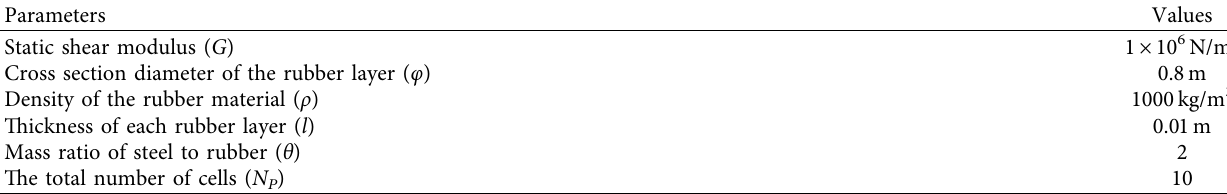
Table 1: The geometric and material parameters of periodic rubber–steel structure.